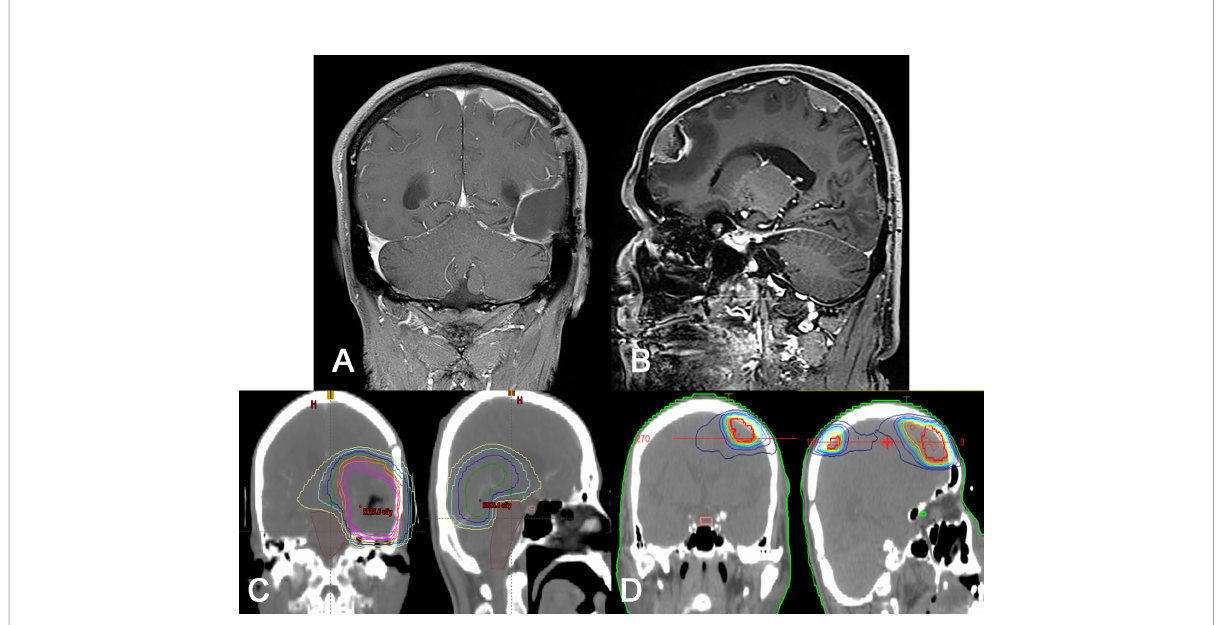
FIGURE 2 Radiological and treatment plan images for recurred lesions. (A, B) Gd-enhanced T1-weighted MRI showing two enhanced, dural based masses along the dura mater of remote site. Note that there is no de fi nitive recurrence on the initial lesion. (C, D) Representative photos of dose plans for initial radiation ( C , 60 Gy) and re-irradiation ( D , 50 Gy) treatments. Note that there is no de fi nitive overlap in radiation fi eld in two dose plans.